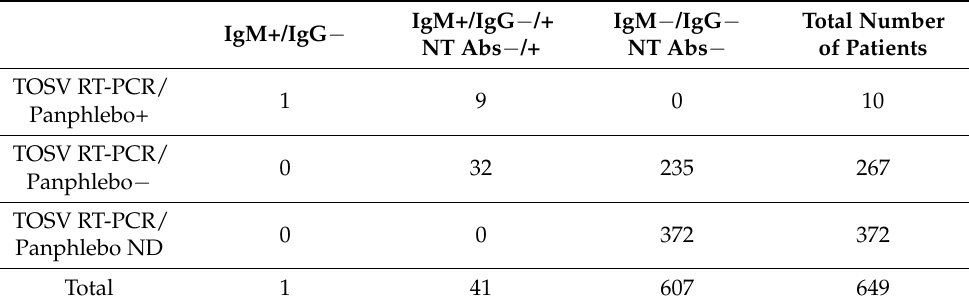
Table 1. Pattern of molecular and serological results in 649 tested subjects.